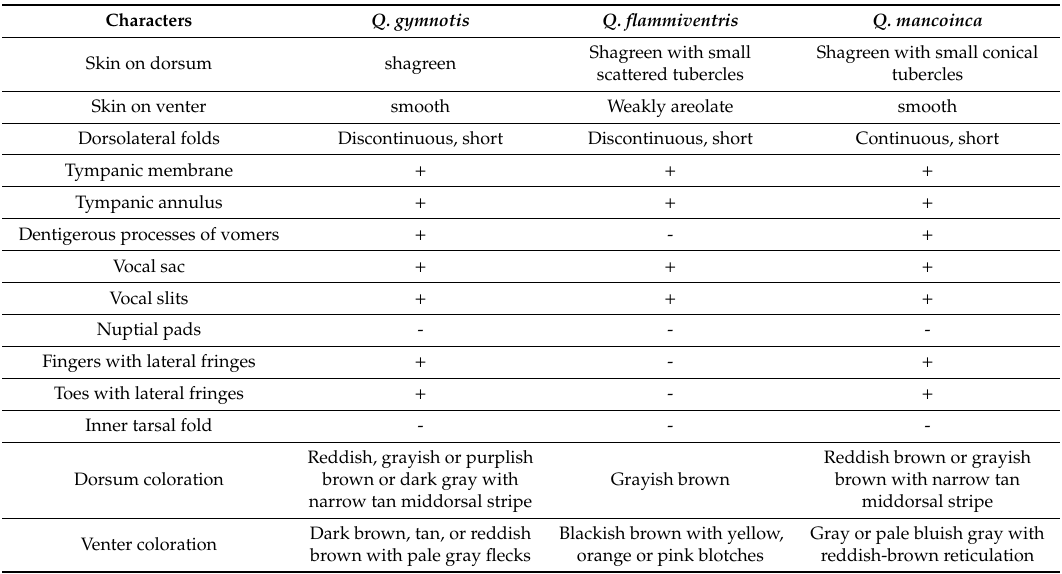
Table 3. Meristic traits ( + = character present, - = character absent) for the three known species of Qosqophryne gen.